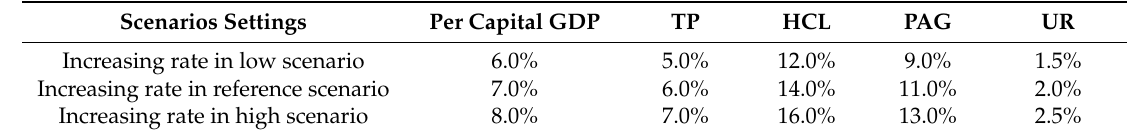
Table 5. The increasing rate of each affecting factor in Low, Reference and High scenarios.